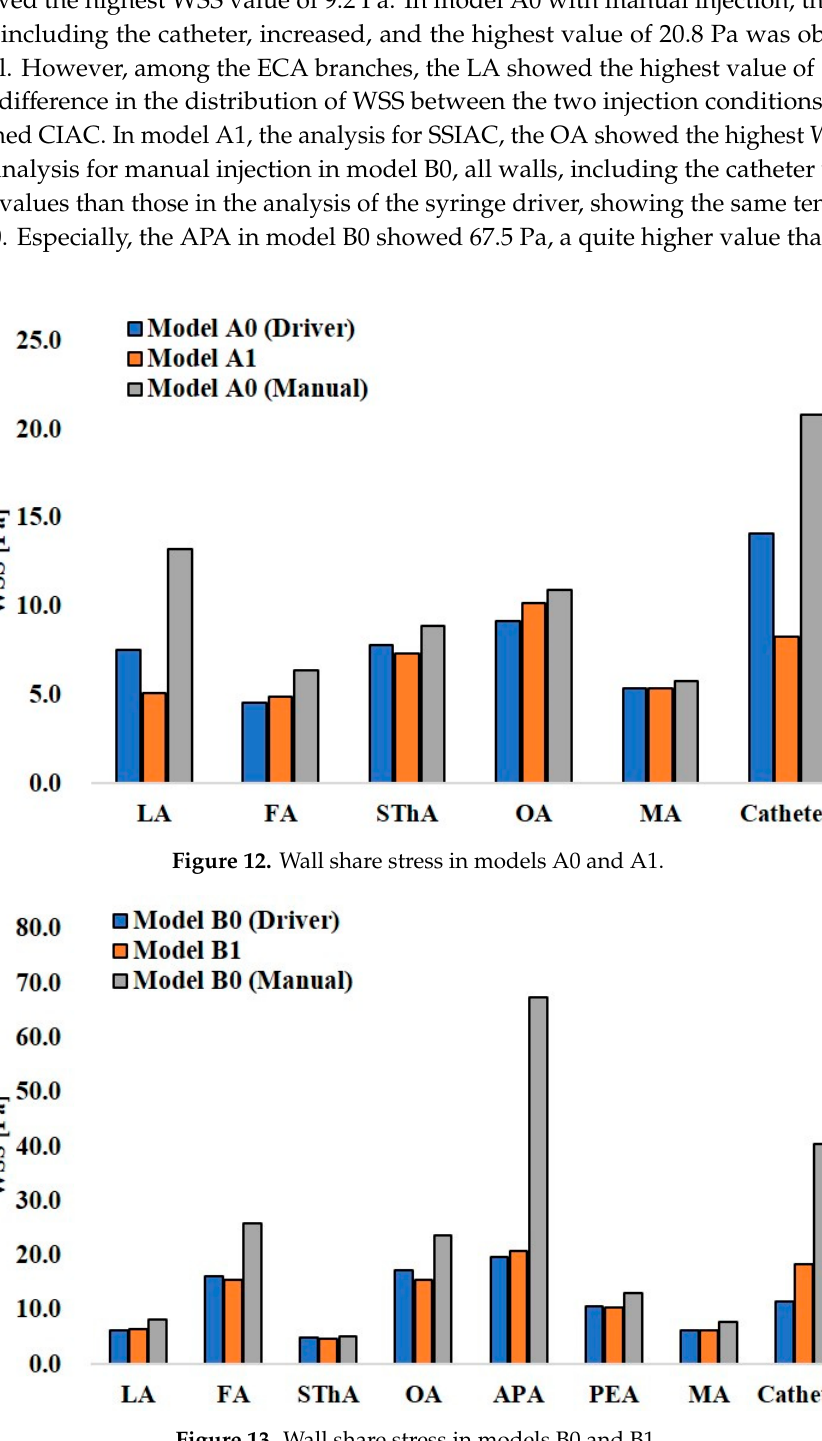
Figure 13. Wall share stress in models B0 and B1.